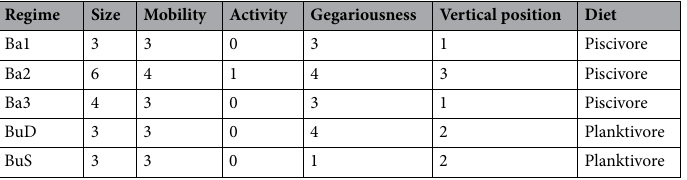
Table 2. Community-weighted-mean values (CWM) for the different traits and fish communities